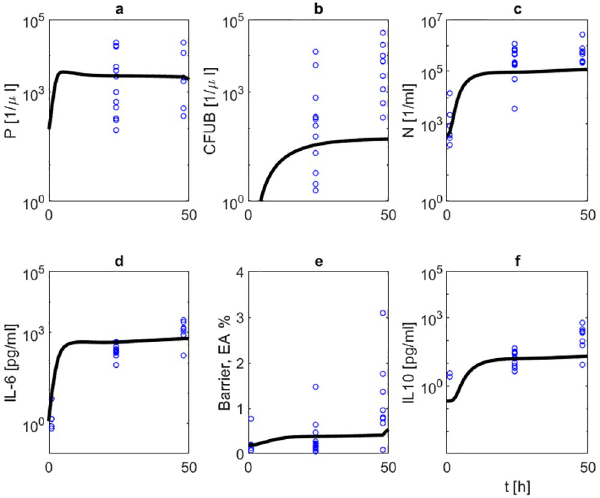
Fig 7. (Treatment with 2 mg/kg NOX-D19). We compare results of model simulation (solid black curve) with data under 2 mg/kg NOX-D19 treatment. Time series of pneumococcal population in BAL (a) and blood (b), neutrophils in BAL (c), IL-6 in BALF (d), barrier function (e) and IL-10 in BALF (f) are displayed. Circles represent data points [2]. NOX-D19 is applied 0 and 24 hours after infection. NOX-D19 treatment alone does not help to eradicate the disease but stabilizes the barrier